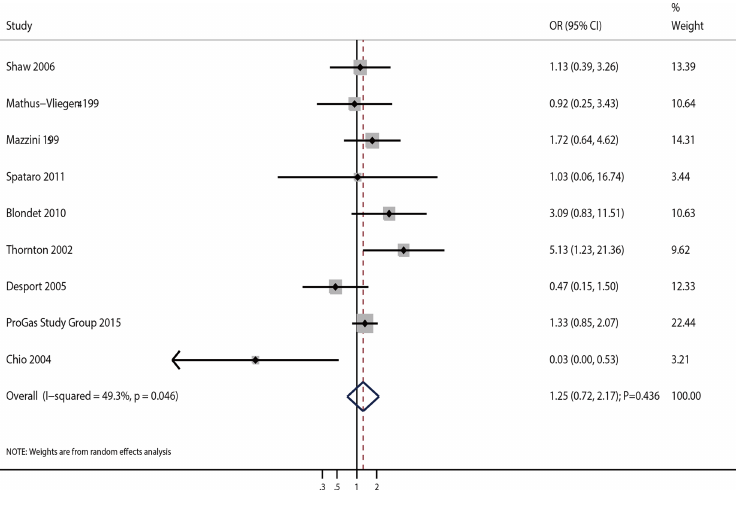
Fig 3. Association of PEG use with 10-month survival rate.